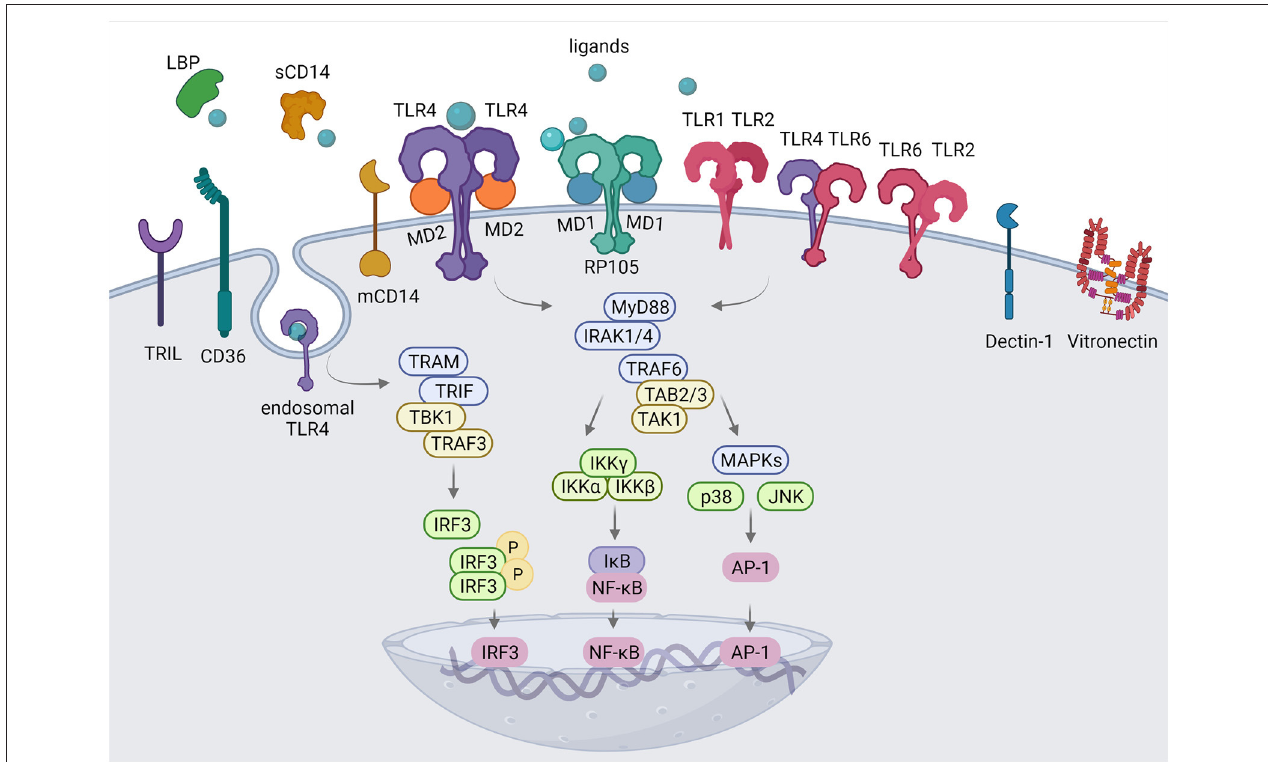
FIGURE 1 | Membrane TLRs and their accessory molecules. Cell surface TLR1, TLR2, TLR4, and TLR6 are essential for the recognition of exogenous and endogenous ligands. TLR1/2, TLR2/6 heterodimers and TLR4/TLR4 homodimer utilize MyD88-dependent pathway to control inflammatory responses via activation of NF- κ B and AP-1 transcription factors, endosomal TLR4 activates TRAM/TRIF-dependent pathway resulting in type I IFN responses. CD36 induces the assembly of the TLR4/6 and TLR2/6 heterodimers. CD14 can be secreted as a soluble molecule (sCD14) or a membrane bound protein (mCD14) and is involved in ligand delivery to several TLRs. LPS-binding protein (LBP) binds to lipopolysaccharide (LPS) and presents it to CD14. MD2 is necessary for TLR4 to bind to LPS and homodimerize. RP105-MD1 complex has a structural similarity to TLR4-MD2 and exerts dual regulatory activity on TLR4 and TLR2 -regulated inflammatory response. Dectin-1 facilitates TLR2 signaling whereas TRIL interacts with ligands to activate TLR4 signaling. Vitronectin enhances TLR2 and TLR4-mediated responses. Created with